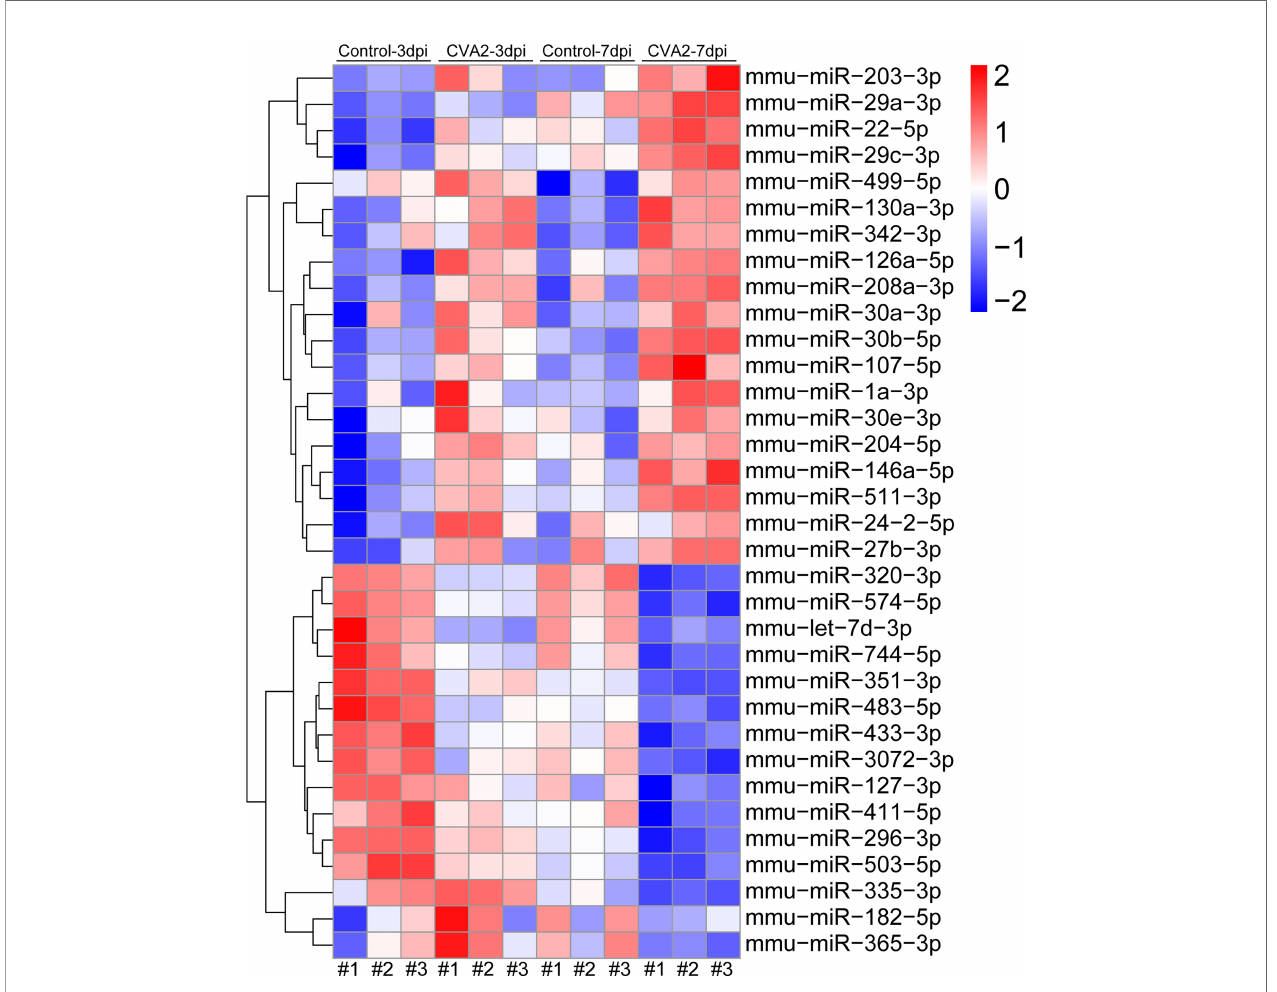
FIGURE 4 | Visualization of differential co-expressed miRNAs in heart tissues of CVA2-infected mice. A total of 34 differential co-expressed miRNAs were identi fi ed in this study. The heatmap of these miRNAs was presented in the fi